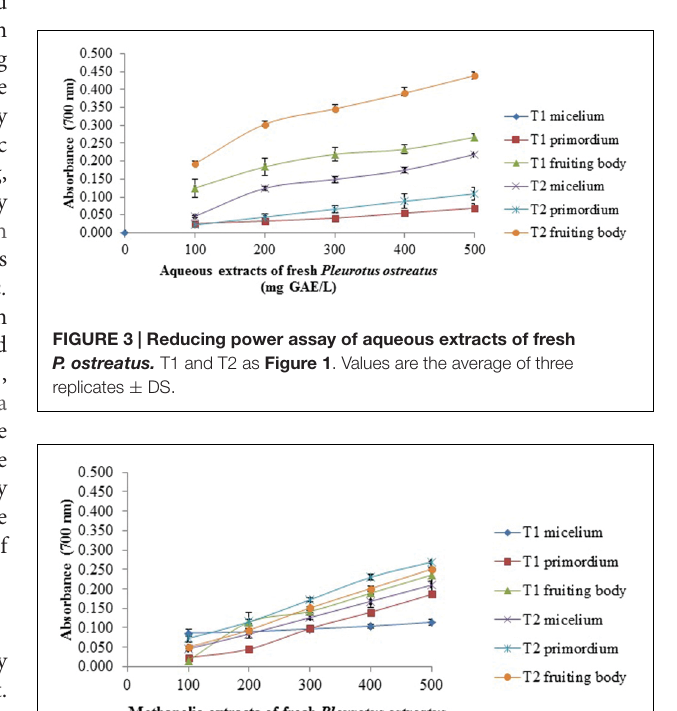
FIGURE 2 | Reducing power assay of methanolic extracts of dry P. ostreatus. T1 and T2 as Figure 1 . Values are the average of three replicates ± DS.